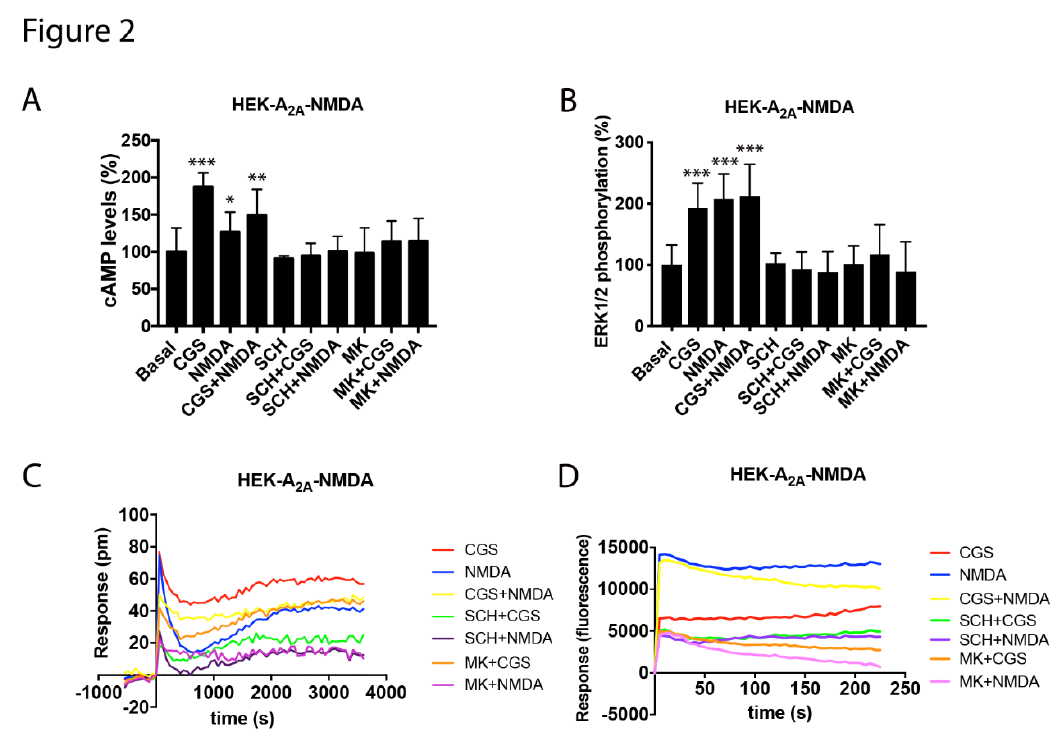
Figure 2. Functional characterization of the A 2A -NMDA receptor heteromer in HEK-293T cells. In ( A ) to ( D ), HEK-293T cells expressing A 2A R (0.5 μg of cDNA), GluN1 (0.5 μg of cDNA) and GluN2 (0.5 μg of cDNA) ( A to C ) or expressing A 2A R (0.5 μg of cDNA), GluN1 (0.5 μg of cDNA), GluN2 (0.5 μg of cDNA) and 6GCaMP calcium sensor (0.75 μg of cDNA) ( D ) were pre-incubated or not with 1 μM of the A 2A R antagonist SCH-58261 (SCH) or with 1 µM of the NMDA antagonist, MK-801 (MK), followed by treatment with 100 nM of the A 2A R agonist CGS-21680 (CGS), 15 µM of NMDA or both, and the cAMP levels ( A ), extracellular signal-regulated (ERK) 1/2 phosphorylation ( B ), representative traces of dynamic mass redistribution (DMR) ( C ) and the representative traces of intracellular Ca 2+